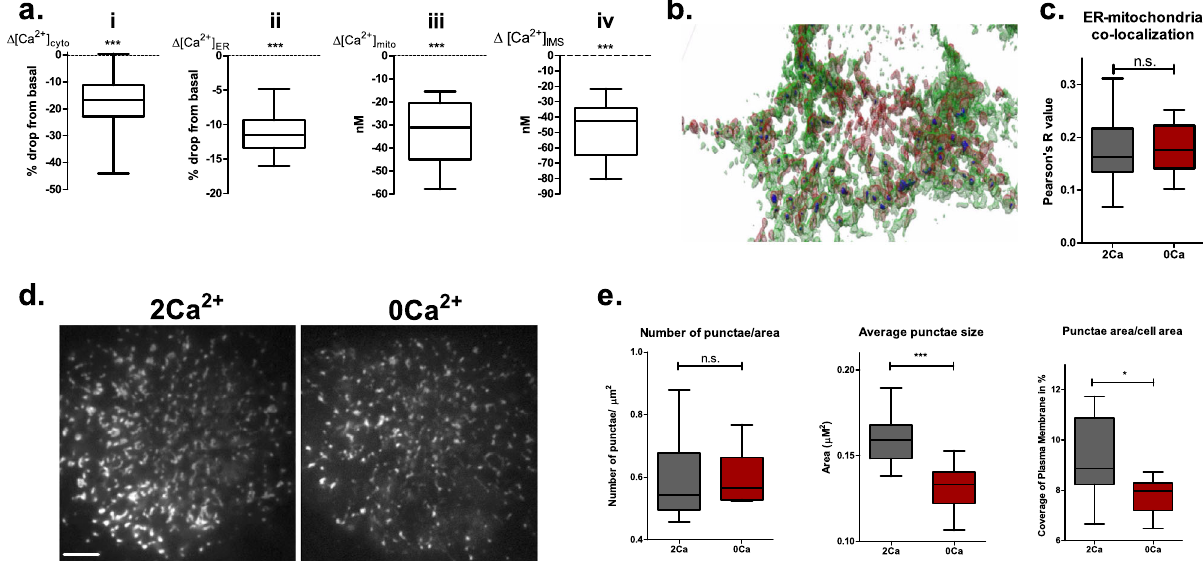
Fig. 1 Removal of extracellular Ca 2 + triggers basal Ca 2 + drop in intracellular compartments and affects ER-PM contact cites. a Removal of extracellular Ca 2 + reduces basal Ca 2 + levels in cytosol ( n = 64), ER ( n = 17), IMS ( n = 13), and mitochondria ( n = 21). b Exemplary 3D reconstruction of EA.hy926 cell with pseudo- colored ER (green) and mitochondria (red) used for analysis of ER-mitochondria contacts (dark blue). c Analysis of ER-mitochondria contacts ( n = 22, unpaired t -test; n.s.; p = 0.68). d Exemplary TIRF images of ER in the plasma membrane proximity in 2 Ca 2 + (left) and 0 Ca 2 + (right) conditions, scale bar (left bottom corner) is 5 µ m. e Statistical analysis of ER-PM contacts (unpaired t -test, n = 9; n.s. p = 0.92,; * p = 0.018; *** p =